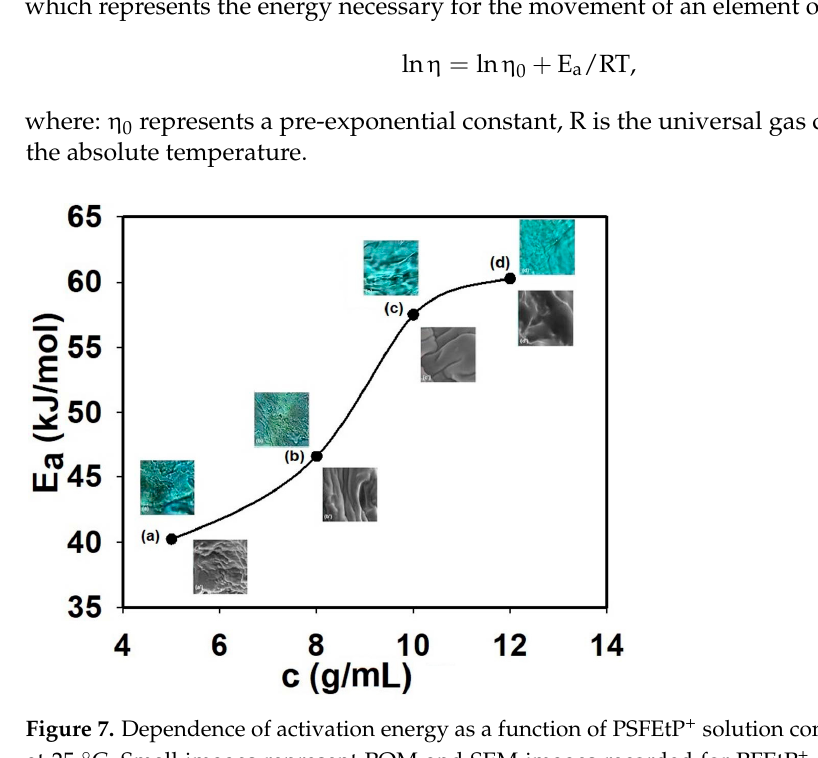
Figure 8. POM ( A ) and SEM ( B ) images for PSFEtP + solutions and corresponding lyophilized sam- ples obtained in DMF at different concentrations: 5.01 g/mL ( a , a’ ), 8.02 g/mL ( b , b’ ), 10.06 g/mL ( c , c’ ), 12.43 g/mL ( d , d’ ). Therefore, SEM image characteristics for less concentrated solutions (Figure 8A(a’)) show the presence of associates generated by the system interactions, and also the appear- ance of some narrow bands (Figure 8B(b’)) which highlights that the gel structures begin to form even from low concentrations. This is explained by the fact that, in the studied systems, the presence of voluminous phosphonium groups can generate rigid confor- mations by intensifying the intramolecular, but also the intermolecular, interactions pro- cess that is more evident with increasing concentration. Thus, it can be assumed that the associates (Figure 8A(a’)) and, implicitly, the strong electrostatic interactions established between the polysulfone chains containing phosphonium groups, which intensifies with increasing concentration, determine the transition from sol to gel. In this context, as im- ages show for high concentrations (Figure 8B(c’,d’)), the bands begin to enlarge, suggest- ing the formation of a more compact gel structure. In addition, as a consequence the